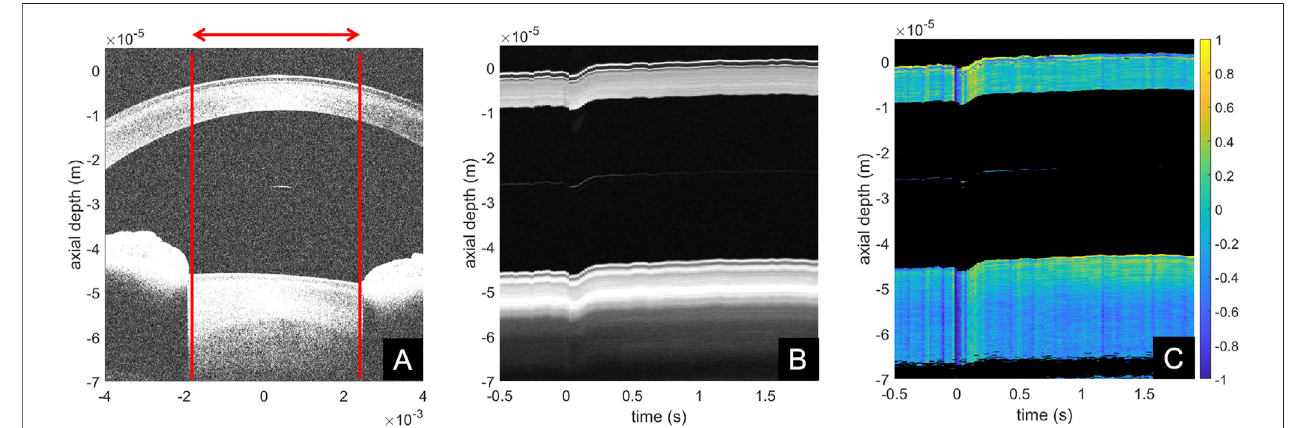
FIGURE 2 | Examples of anterior segment (A) structural cross-sectional B-scan, (B) structural temporal M-scan representation, (C) phase difference temporal M-scan representation.